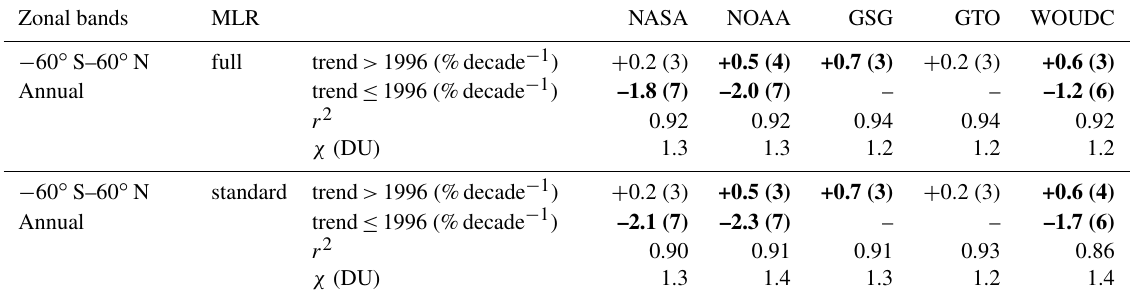
Table 5. The 1979–1996 and 1997–2016 annual and near-global mean total ozone trends. For further information on variables, see Table 3. Results are from the standard MLR and the full MLR including BDC terms from both hemispheres and the AO term. Zonal bands